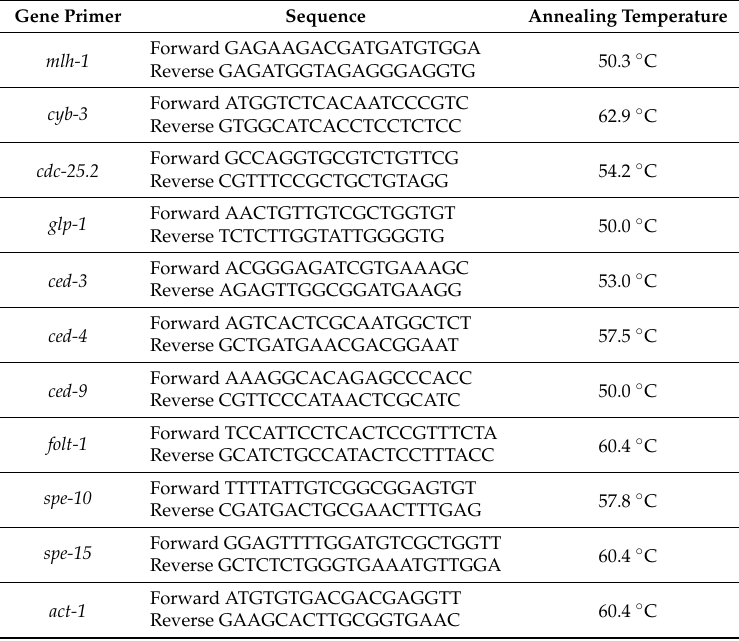
Table 1. Gene primers tested in the